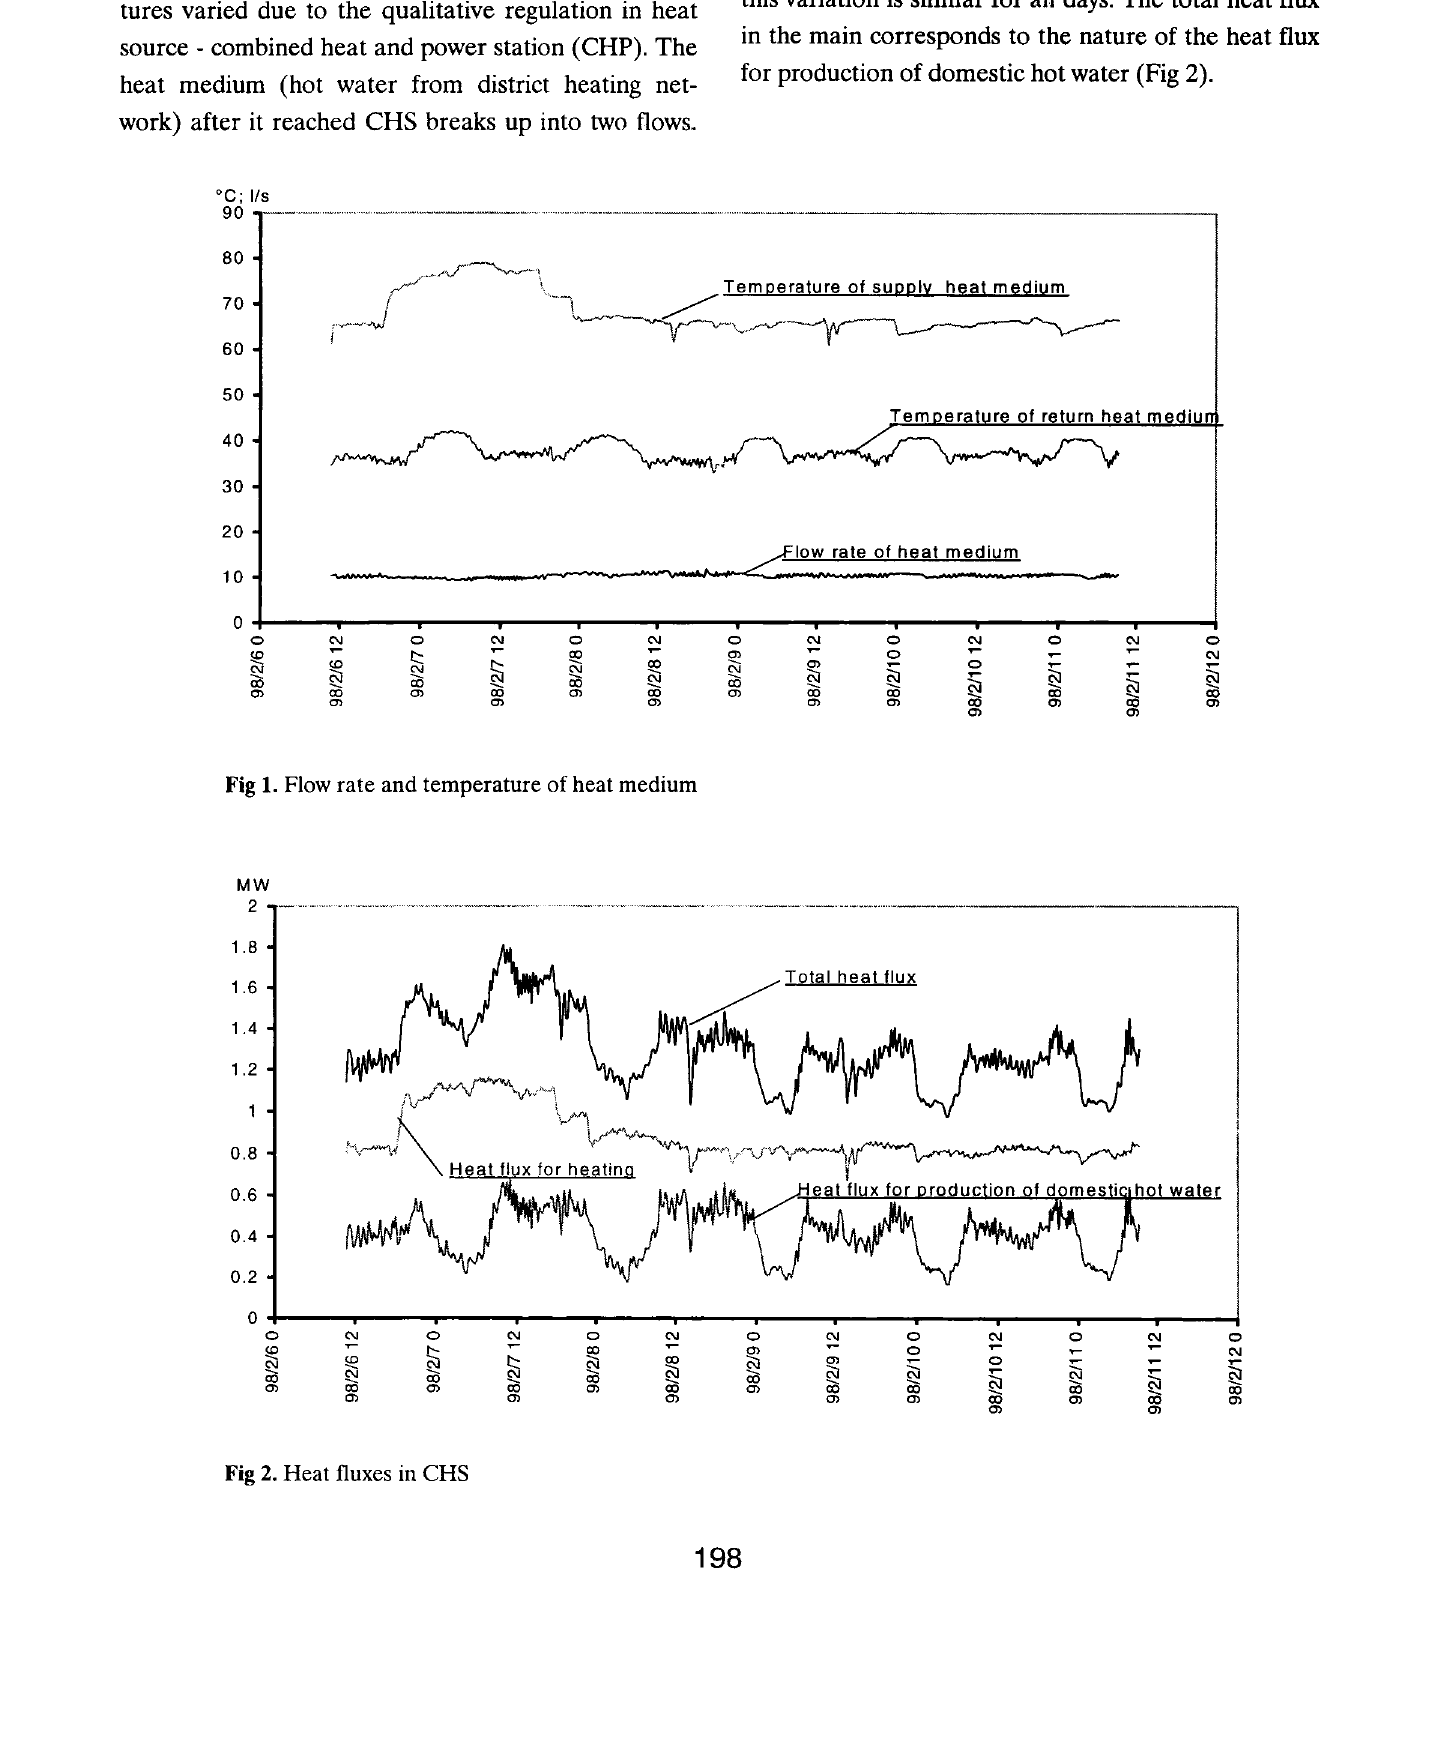
Fig 2. Heat fluxes in